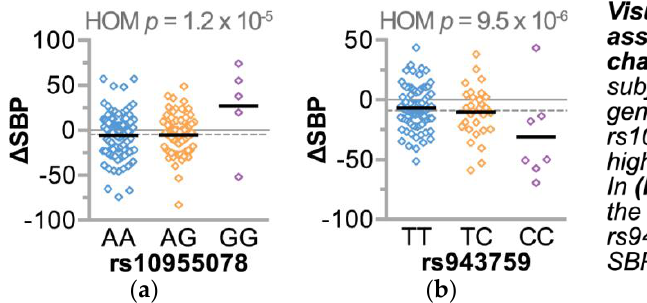
Figure 4. The SNP main effect associated with a change in blood pressure after 12 months of the intervention. The change in SBP (ΔSBP) after 12 months of the intervention in either ( a ) AA or ( b ) CAU study participants ( n = 193 and 123, respectively), represented by a dot plot and summarized by the median. The p value of the association of the HomSNP variable (HOM) with ΔSBP for each SNP is indicated. The dashed line represents the mean ΔSBP for each cohort.